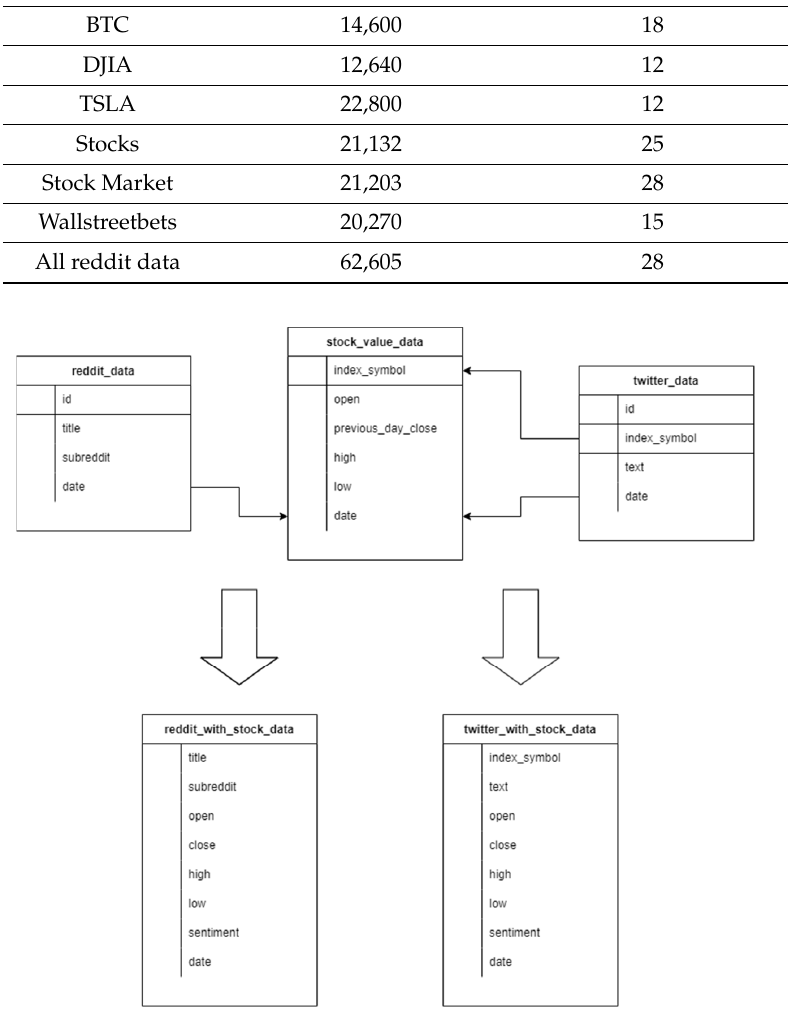
Figure 10. Test dataset.